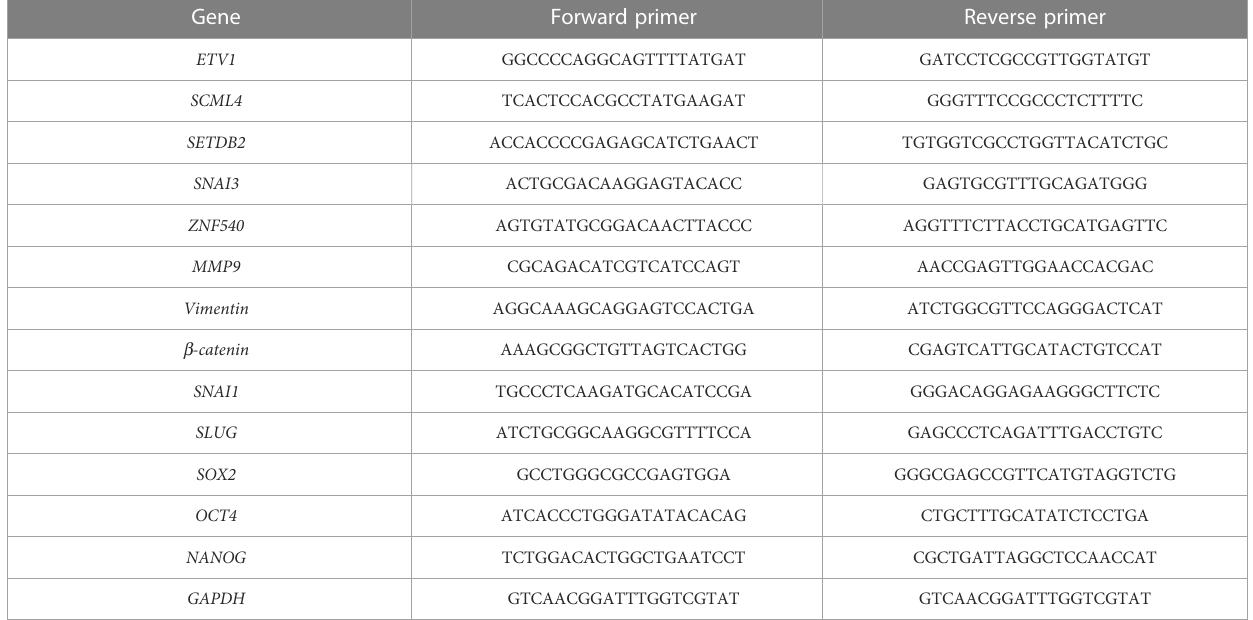
TABLE 1 The primers of select